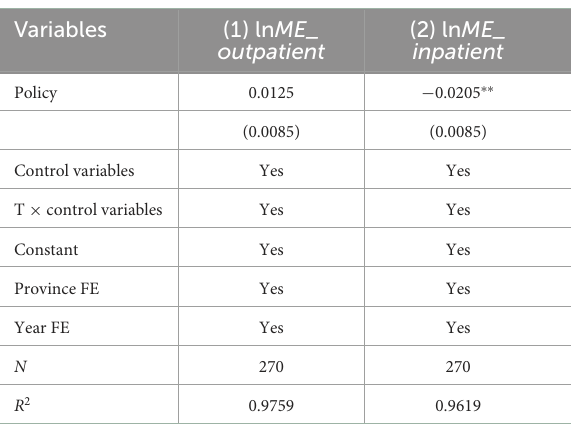
TABLE 6 Control time trend. TABLE 7 Change sample